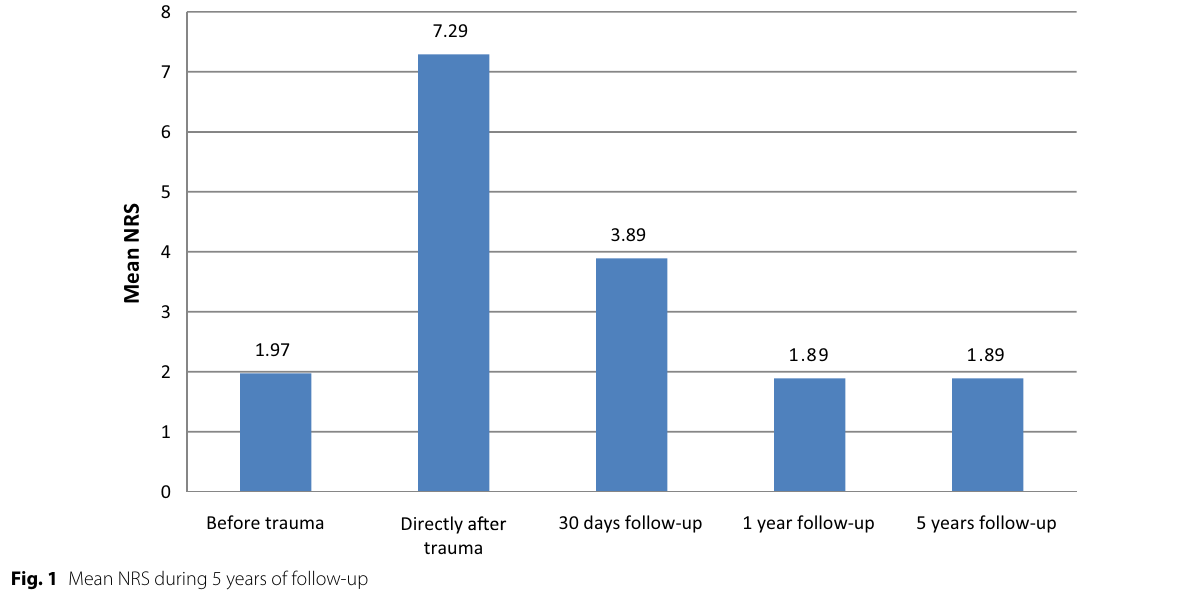
Fig. 1 Mean NRS during 5 years of follow-up